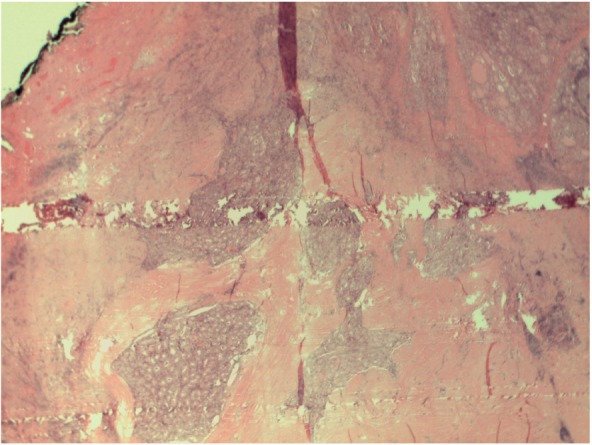
The sclerosing variant of papillary carcinoma with inflammation, sclerosis.